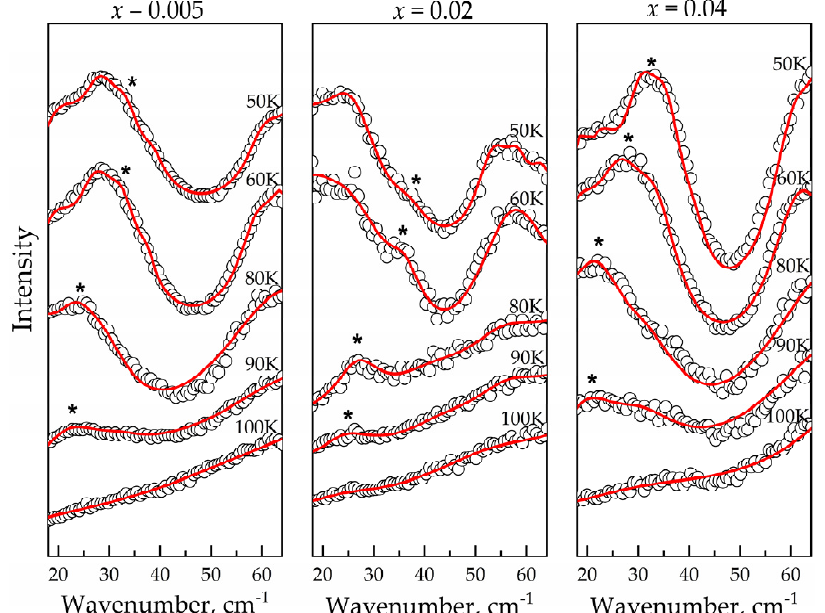
in Figure 3, Raman spectra of the PST x with x = 0.005, 0.02, 0.04 also reveal two intensive peaks, centered at ~22–29 cm − 1 and at ~58–65 cm − 1 separated by the dip at ~45 cm − 1 . According to the phase T - x diagram [32], low- x PST x have the non-polar I 4/ mcm phase at low temperatures.